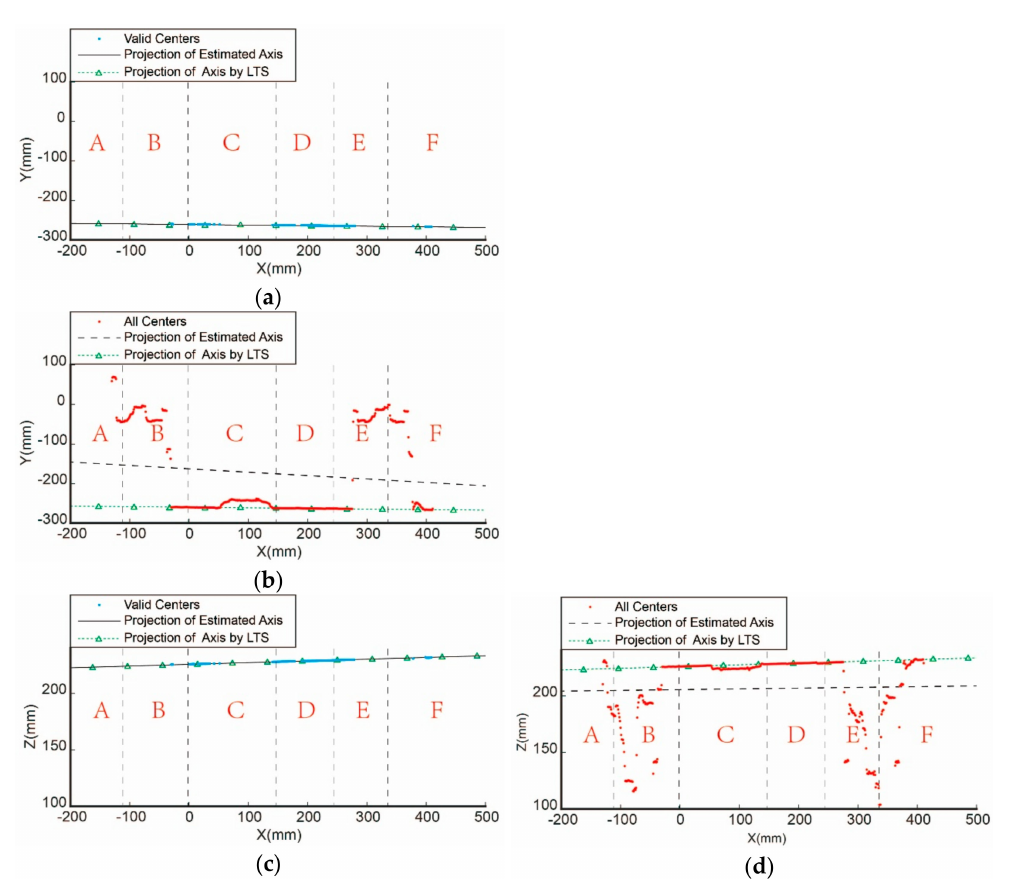
Figure 10. Comparison of the estimated center and axis by the robust method and the non-robust method: ( a ) Projection of the estimated centers and axis on the XOY by the proposed method; ( b ) projection of the estimated centers and axis on the XOY by the non-robust method; ( c ) projection of the estimated centers and axis on the XOZ by the proposed method; ( d ) projection of the estimated centers and axis on the XOZ by the non-robust method.